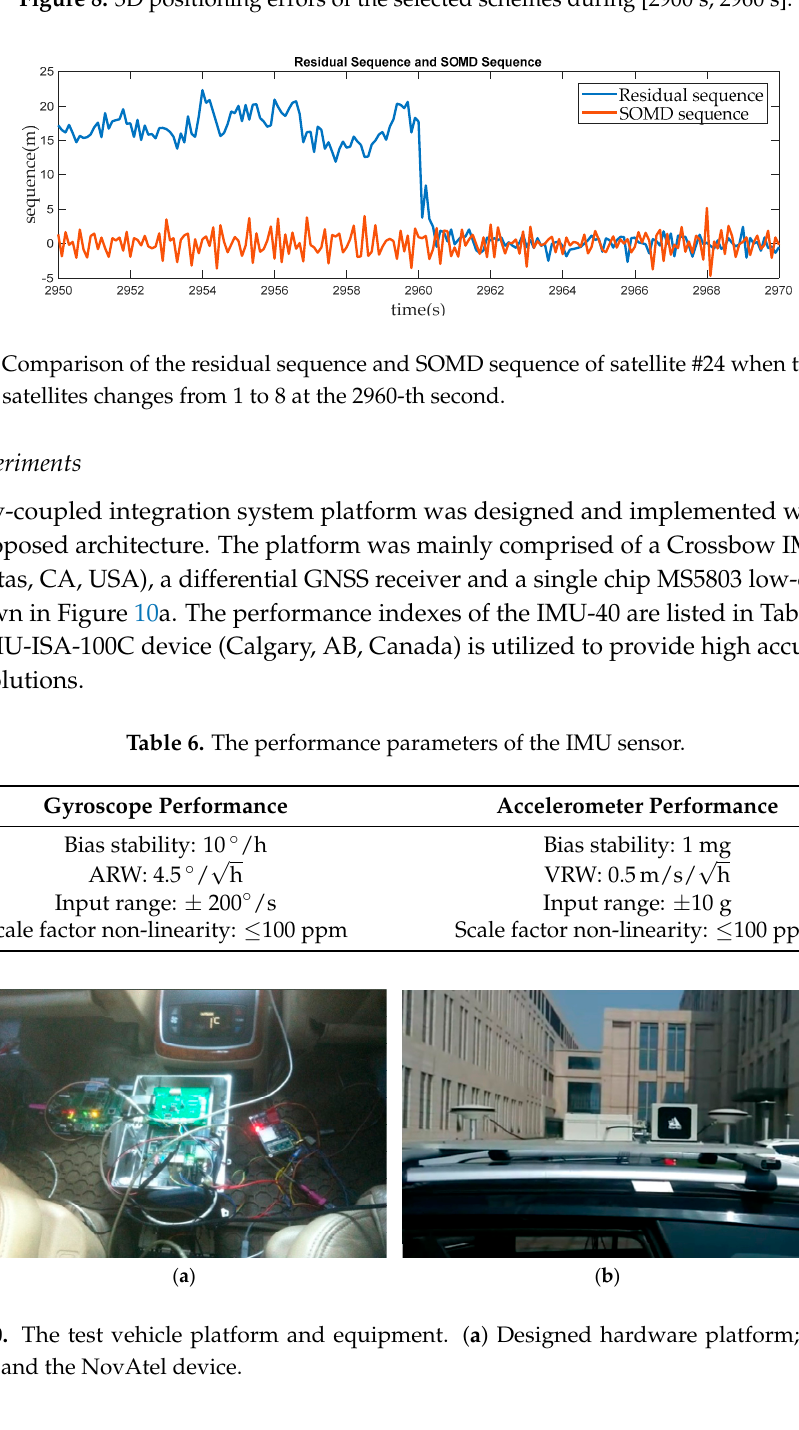
Figure 8. 3D positioning errors of the selected schemes during [2900 s, 2960 s].